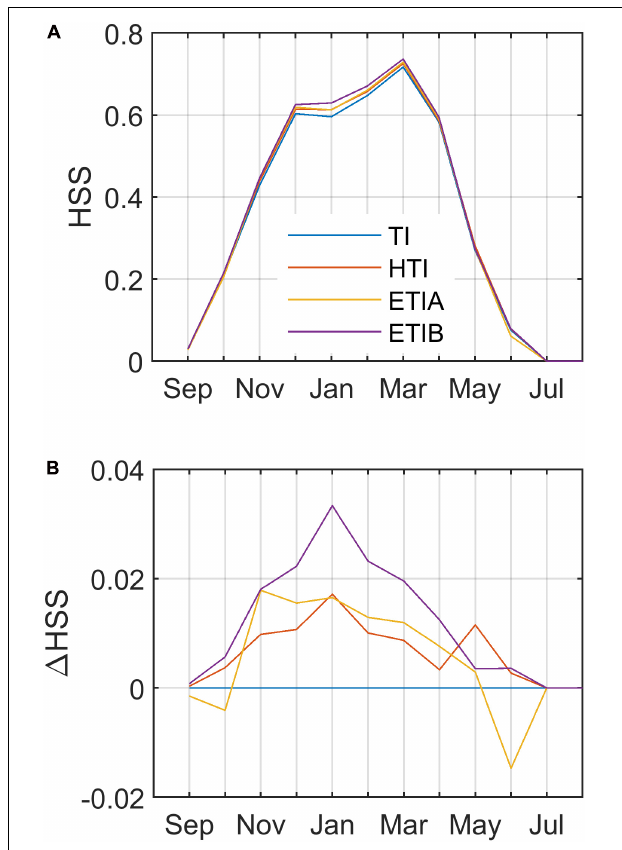
FIGURE 6 | Seasonal model performance. (A) Mean seasonal cycle of HSS index over the whole 2003–2016 period. (B) Differences between enhanced radiative models and the reference temperature index (TI) model.